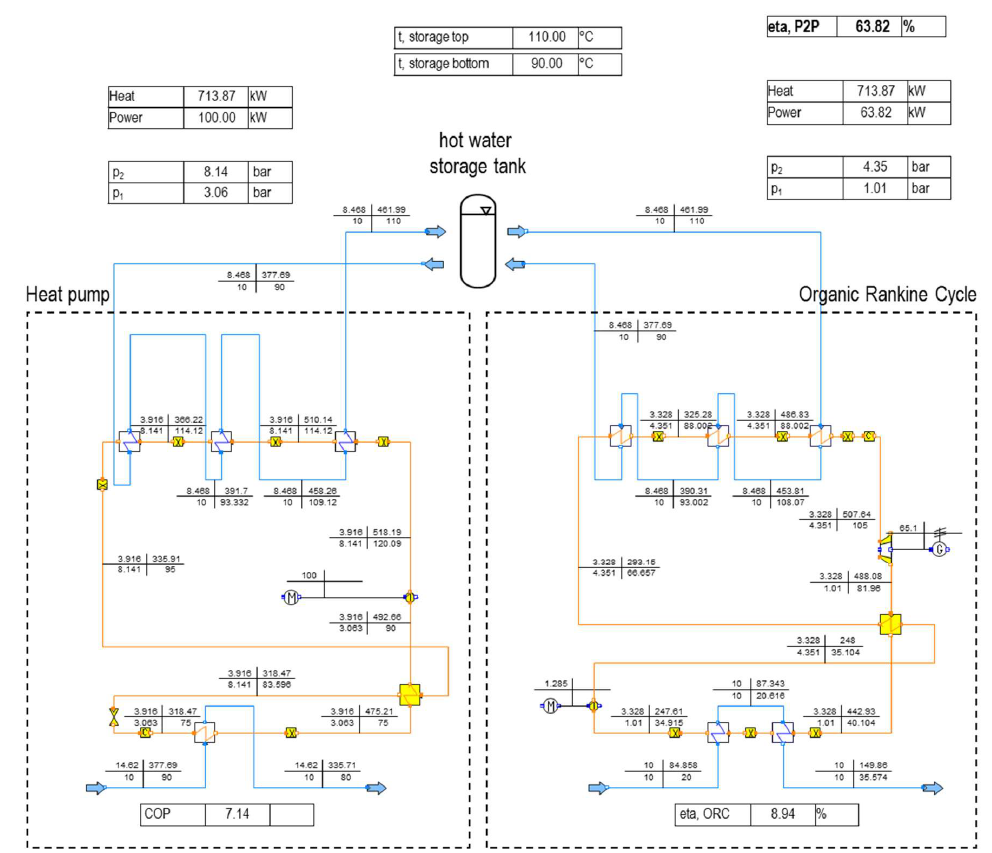
Figure 8. IPSEpro simulation of a process design with additional recuperation and optimized temperature spread of the water storage (isentropic efficiencies of compressors and expanders 70%, waste heat temperature 90 °C, ambient/ORCs condenser temperature 40 °C, terminal temperatures at the pinch points 5 K).